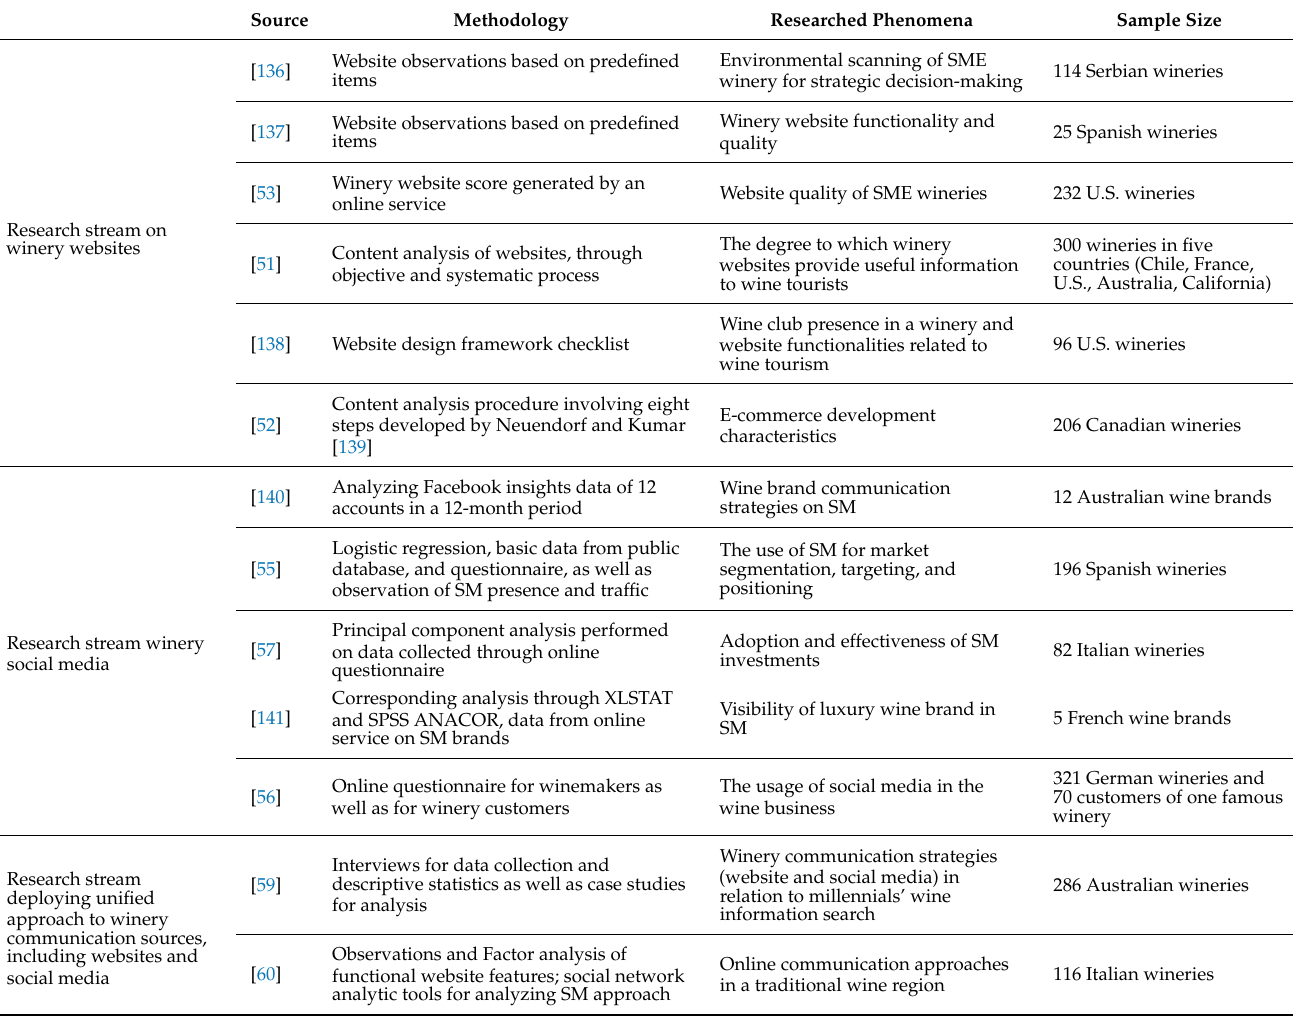
Table A1. Research field of winery online